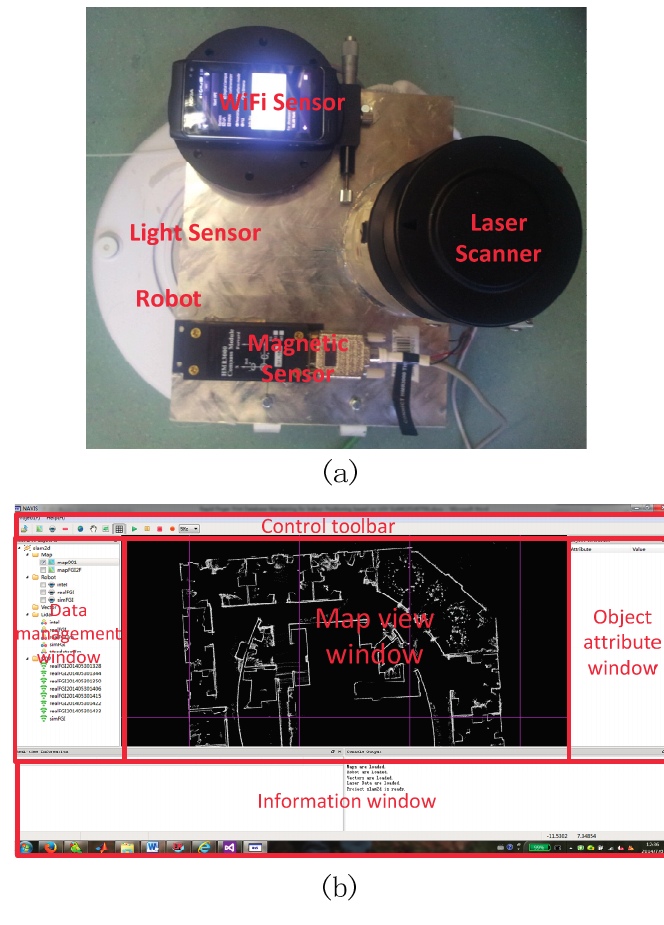
Figure 3. ( a ) The hardware platform of real time UGV SLAM NAVIS; ( b ) the